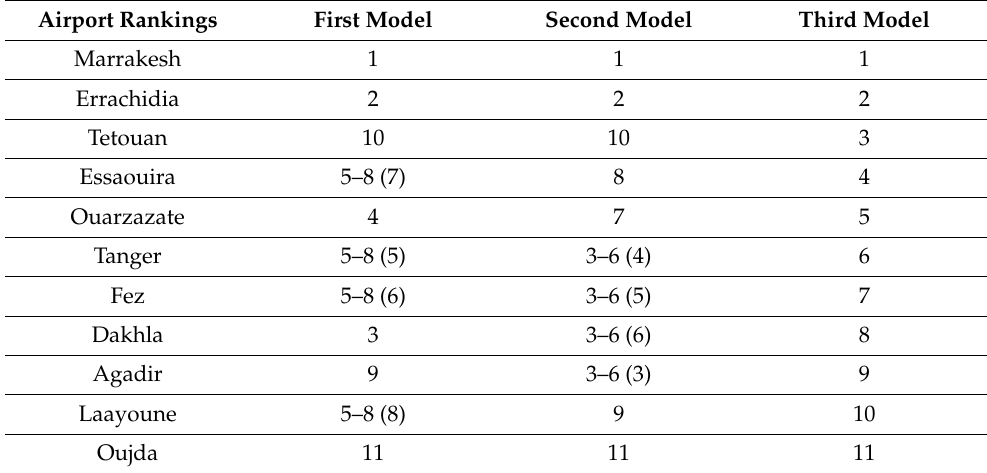
Table 7. Summary of airport rankings in different models. Complete ranking by the Ranked Pairs method in